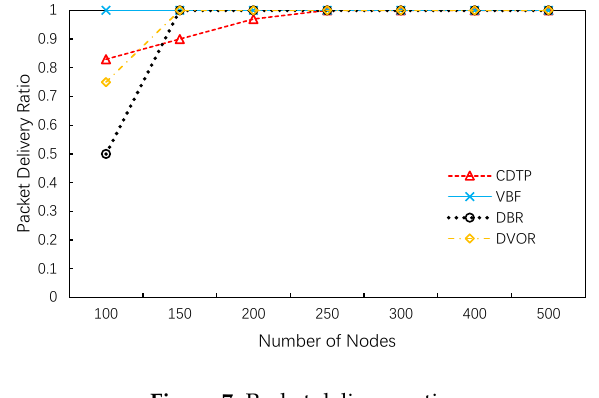
Figure 7. Packet delivery ratio.